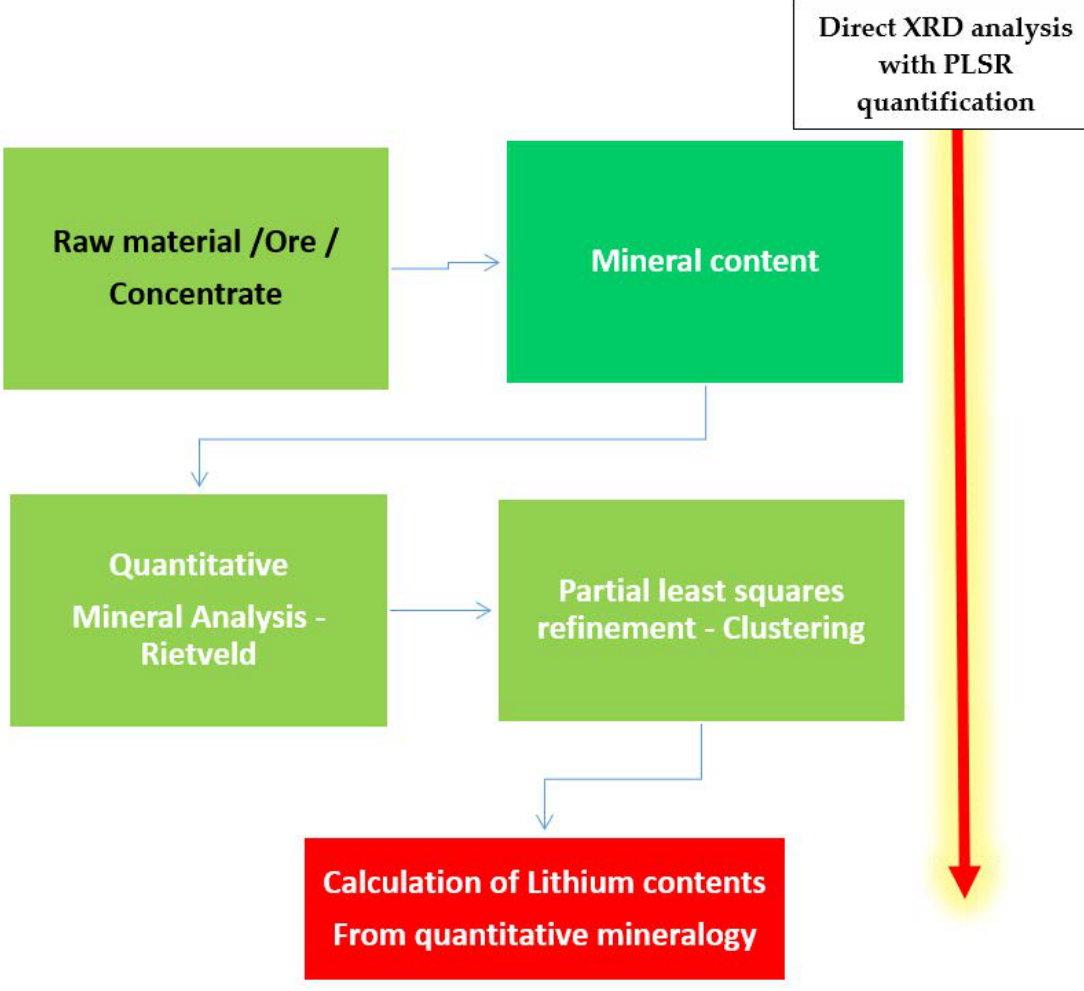
Figure 45. Schematic procedure of lithium determination in lithium ores by